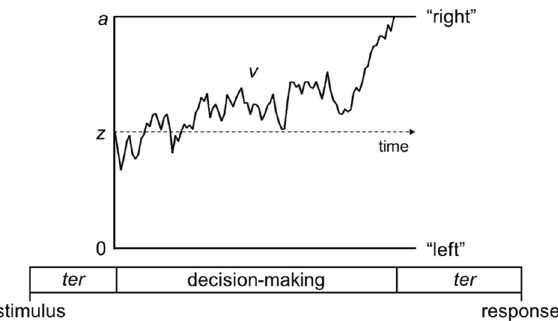
Figure 1. Schematic representation of the main diffusion model parameters. Within the diffusion model, the decision-making process is represented as a noisy evidence accumulation process originating from a starting point, z , towards one of two decision bounds (e.g., “left” and “right” directions in the motion tasks used in this study). Boundary separation, a, reflects the distance between the two bounds, indexing response caution. Drift- rate, v, is the rate of evidence accumulation. Non-decision time, ter , is the time taken for non-decision processes including sensory encoding and response generation. Figure reproduced from https:// osf. io/ rqw62/ under a CC-BY4.0